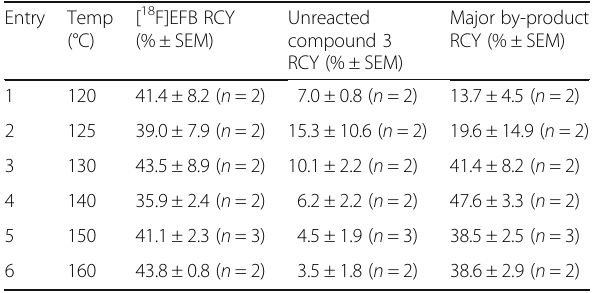
Table 5 HPLC monitoring of the n.i RCY of [ 18